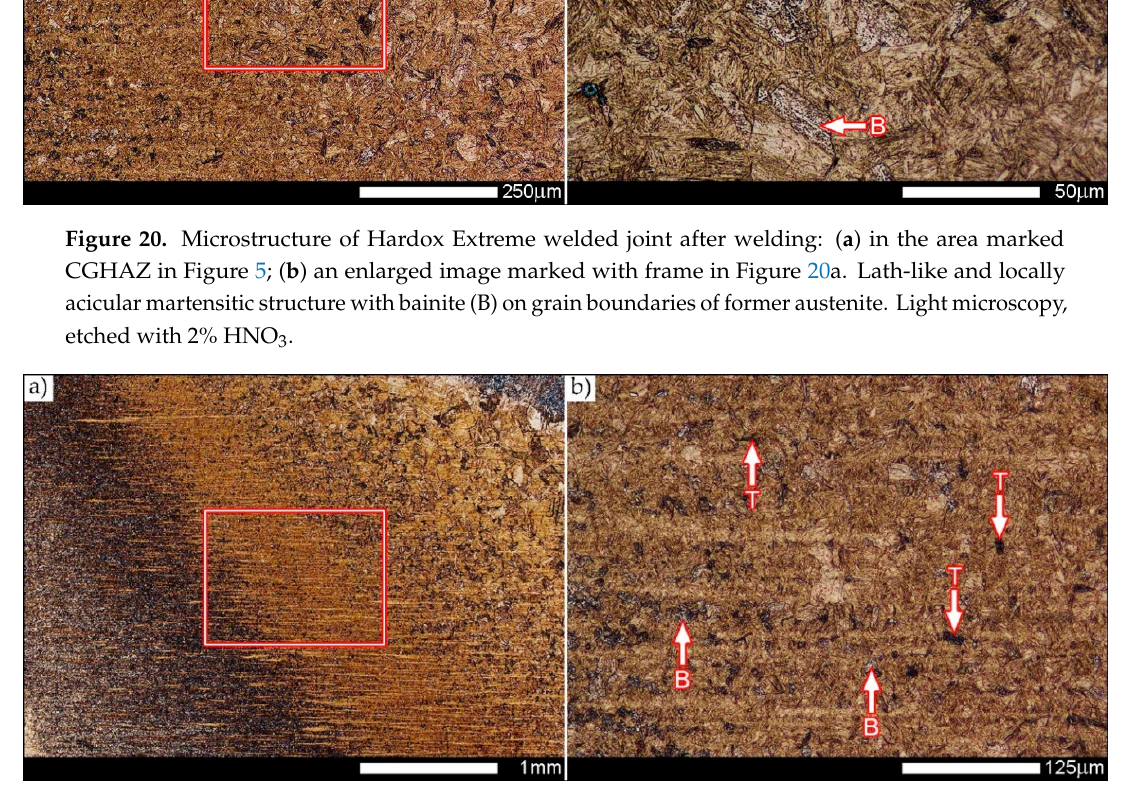
Figure 21. Microstructure of Hardox Extreme welded joint after welding: ( a ) in the area marked FGHAZ in Figure 5; ( b ) an enlarged image marked with frame in Figure 21a. Structure of fine-lath hardening martensite with inclusions of bainite (B) and troostite (T). Light microscopy, etched with 2% HNO 3 .